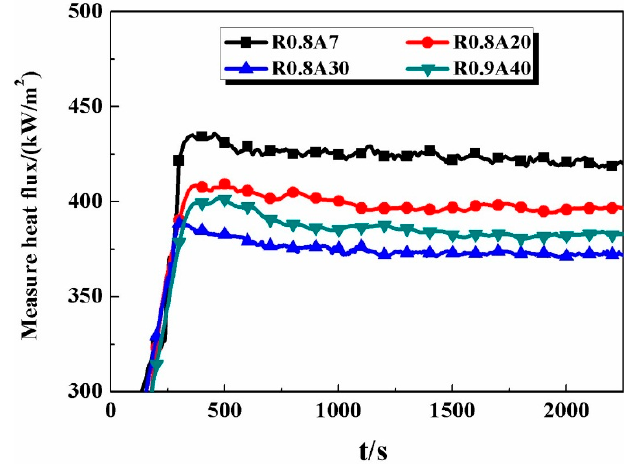
Figure 10. The measured heat fluxes histories of mold fluxes with different amounts of Al 2 O 3 .